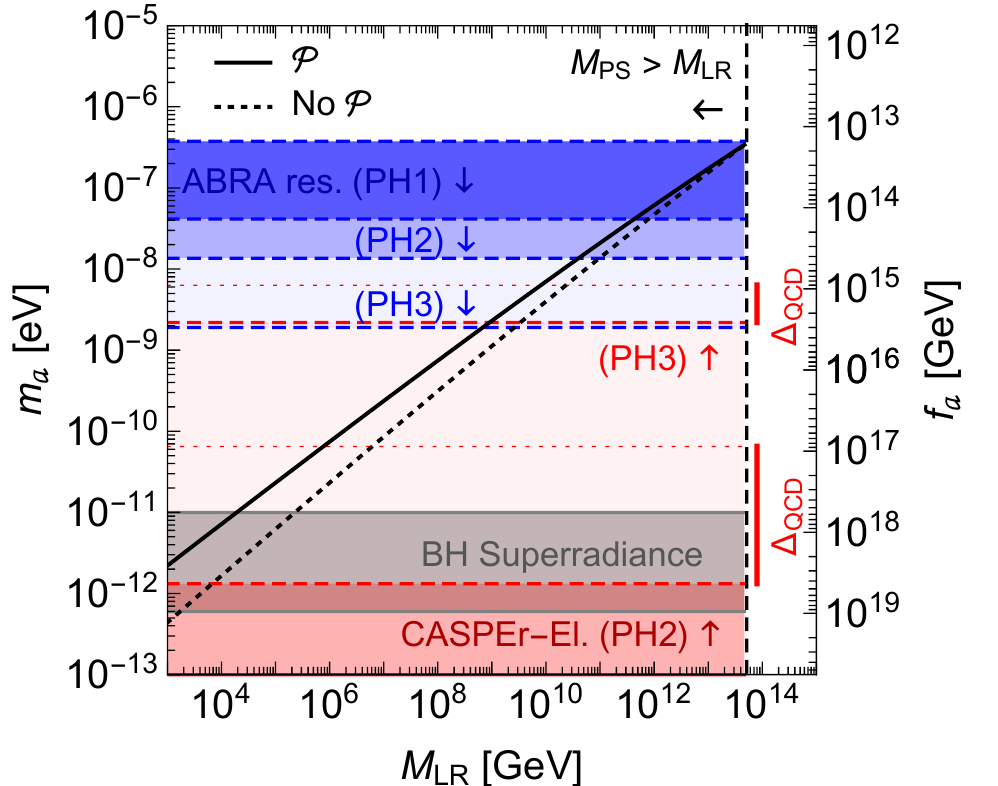
Figure 3 . Axion mass dependence from the Left-Right symmetry breaking scale (from two-loop RG analysis). The full (dotted) black line corresponds to the case where P is broken at the M LR ( M PS ) scale. The current bound from Black Hole Superradiance (gray) and the future reach in di(cid:11)erent phases of ABRACADABRA (blue) and CASPEr-Electric (red) are shown as well (see text for